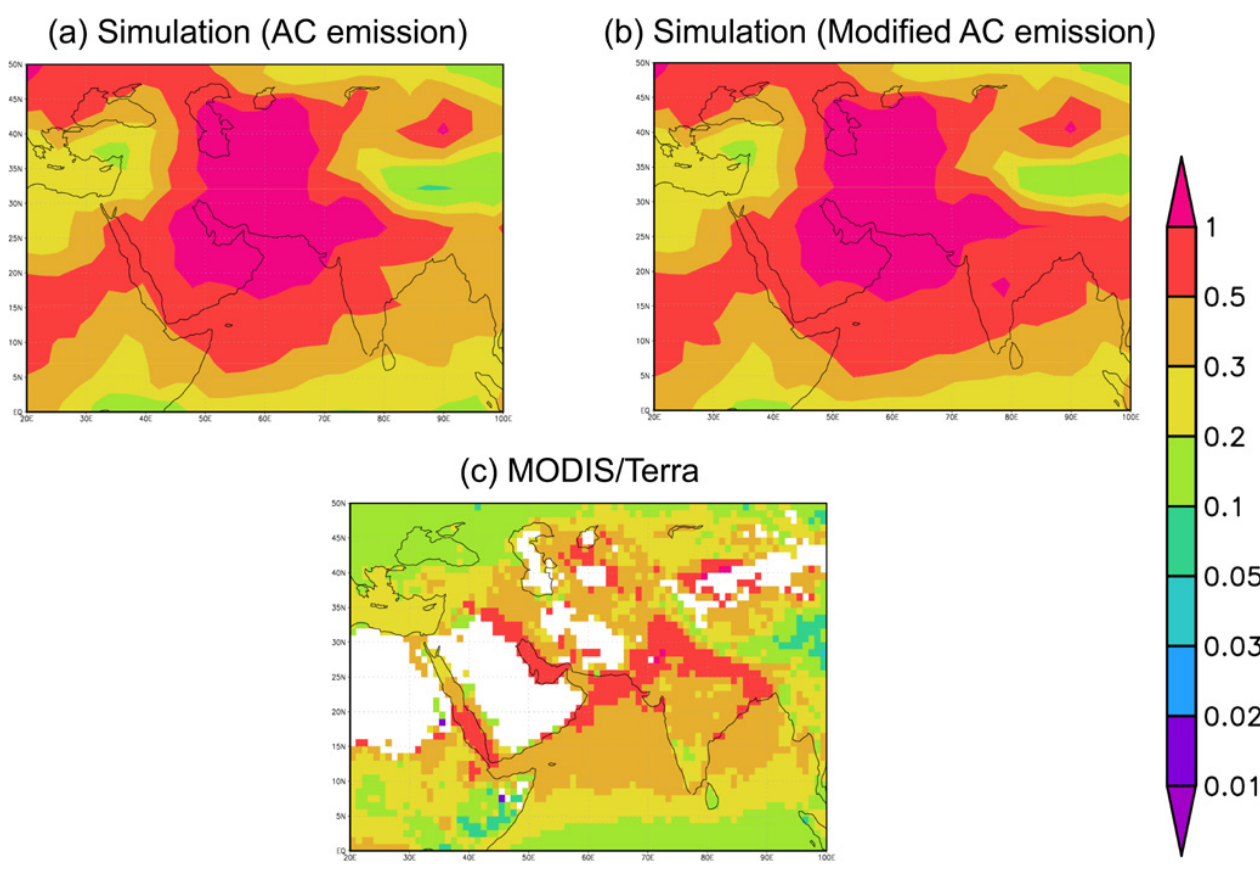
Fig. 5. Mean annual AOT distribution around India for the year 2008. (a) Model simulation with AC emission inventory. (b) Model simulation with modified AC emission inventory. (c)